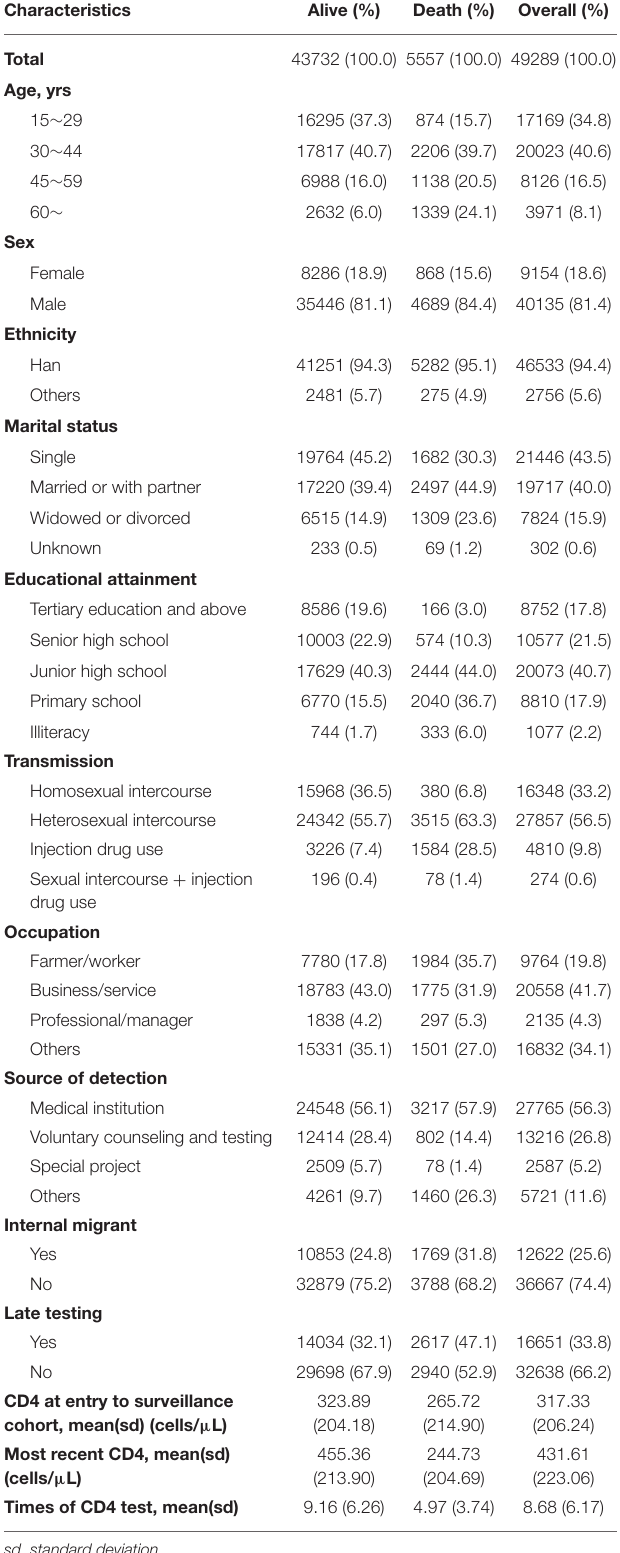
TABLE 1 | Characteristics of people living with HIV recruited in the surveillance cohort.